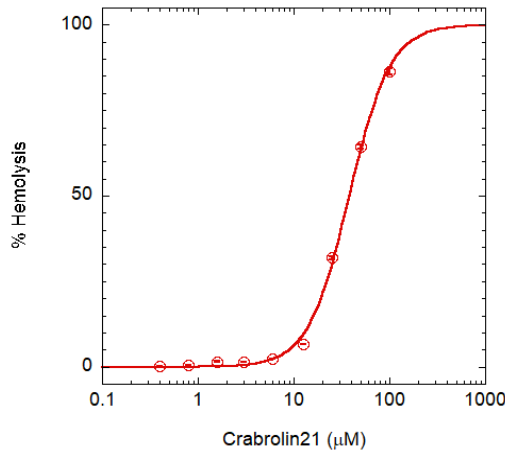
Figure 4. RBC lysis assay. The assay is based on hemoglobin release; circles are the experimental data points, while the continuous line is a guide for the eye. Error bars indicate the interval of duplicate measurements.